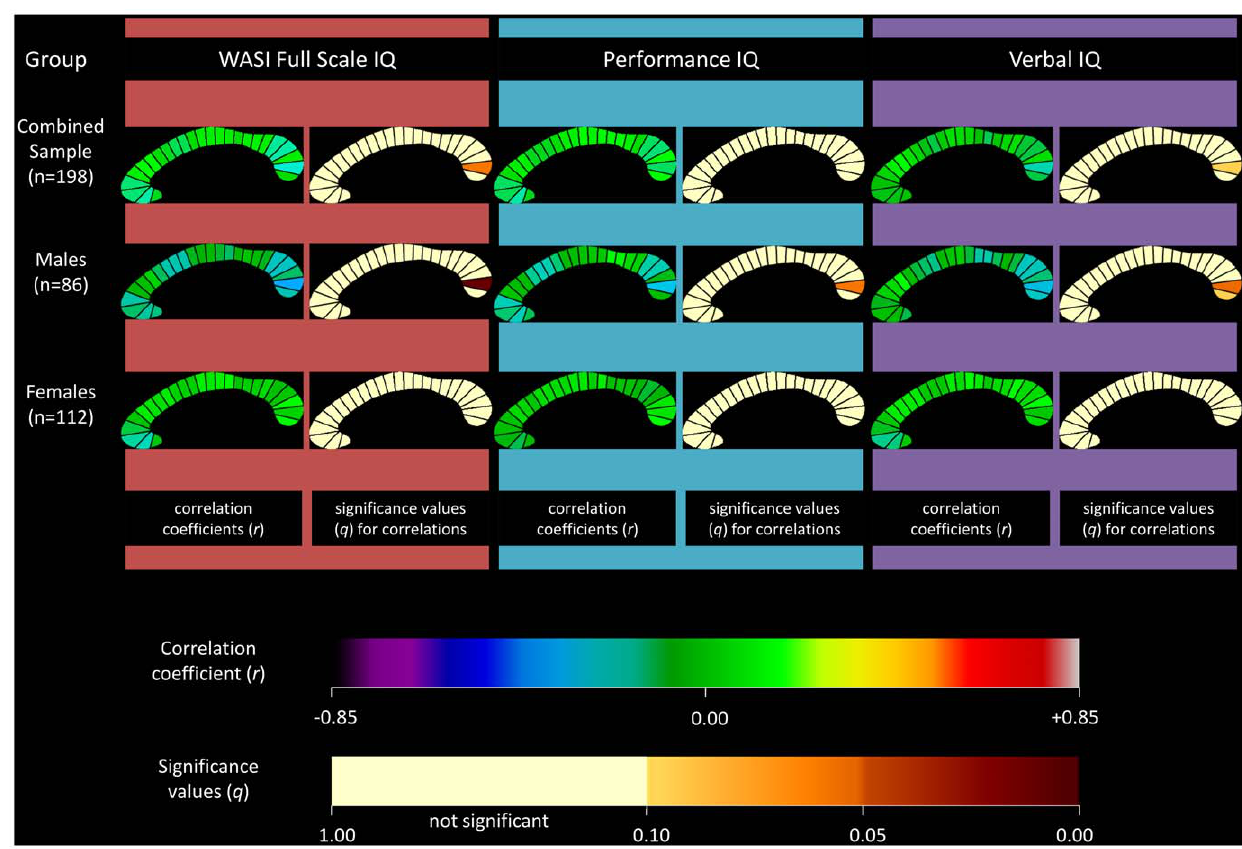
Figure 3. Correlations between corpus callosum midsagittal area and IQ: combined sample and sample partitioned by gender. Partial correlation coefficients and associated significance values for Full-Scale IQ measurements are shown in the first and second columns of callosal maps. Correlation coefficients and associated significant values for Performance IQ are shown in the third and fourth columns, and for Verbal IQ in the fifth and sixth columns. The combined sample is shown in the first row, the males in the second row, and the females in the third row. The upper color bar encodes the r -values that depict the magnitude and direction of correlations, and the lower color bar encodes the level of significance.